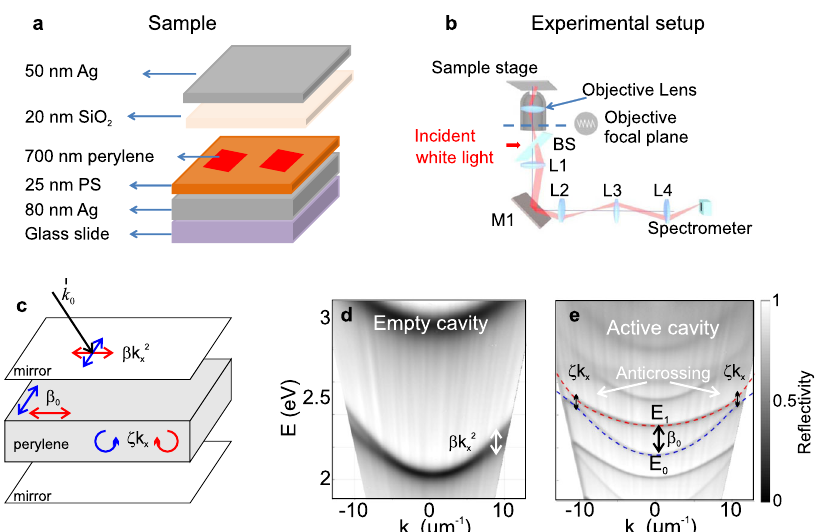
Fig. 2 Combining the spin-orbit couplings. a The sample consists of a perylene crystal embedded in a microcavity. b Experimental setup allowing to obtain polarization-resolved complete state tomography. BS: beam splitter; L1 – L4: lenses; M1: mirror. The red beam traces the optical path of the re fl ected light from the sample at a given angle. c Embedding the perylene crystal in a planar cavity combines TE-TM splitting β k 2 , linear birefringence β 0 , and emergent OA ζ k x . d Re fl ection of an empty cavity versus energy and wave vector, which evidences the k-dependent TE-TM splitting β k 2 . e Re fl ection of a cavity fi lled with perylene, which is inducing linear birefringence β 0 on top of the cavity-induced TE-TM splitting, leading to emergent OA ζ k x (black arrows). Dashed lines show a fi t of the two coupled bands with the Hamiltonian (4). The axes of the polarizer and the excitation direction k x are aligned with the fast axis of the crystal. The fi gures are measured for a fi xed angle range; white regions appear due to angle-to-wave vector